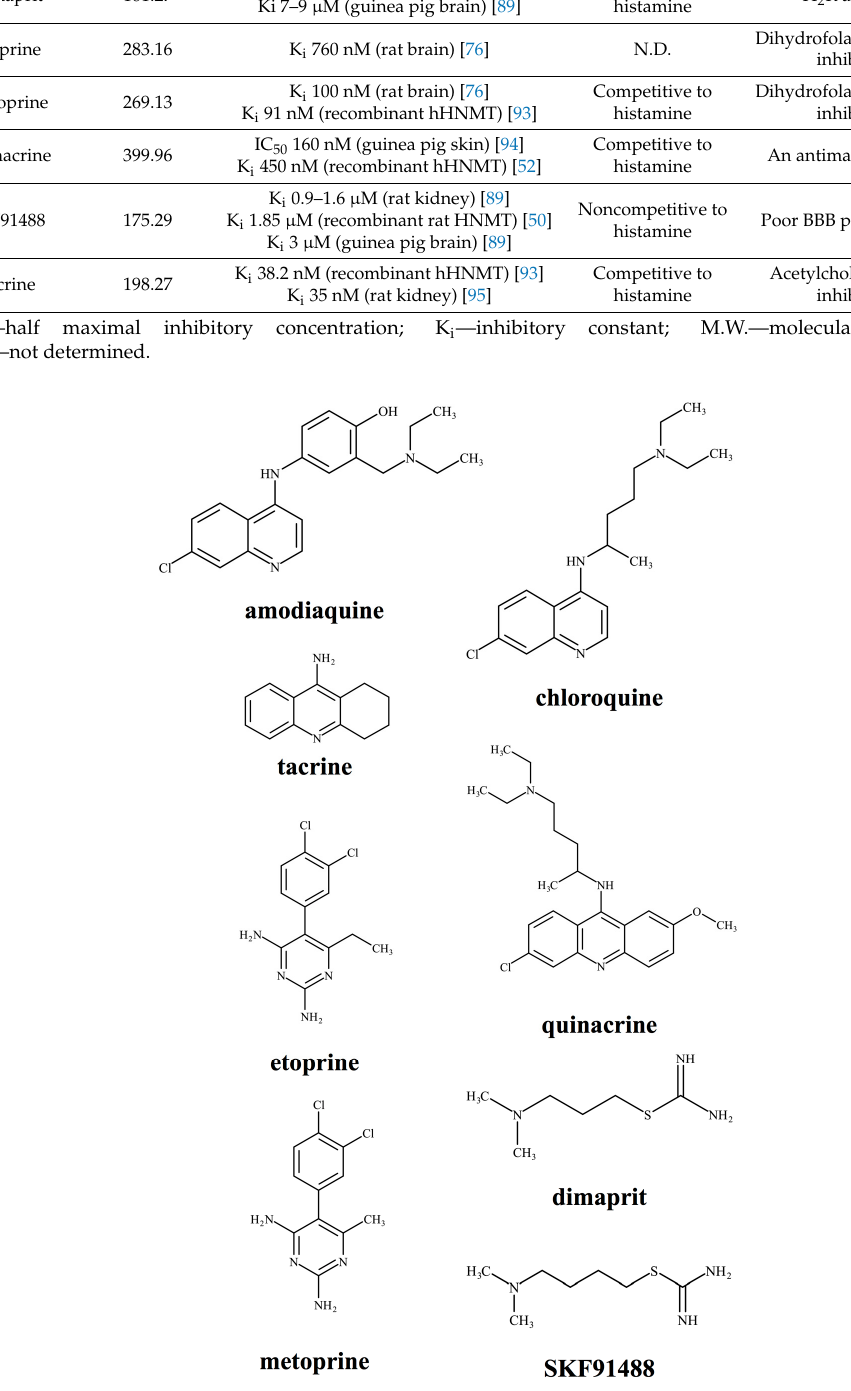
Figure 3. Structures of HNMT inhibitors. Structures of typical HNMT inhibitors amodiaquine, tacrine, etoprine, metoprine, chloroquine, quinacrine, dimaprit, and SKF91488 are